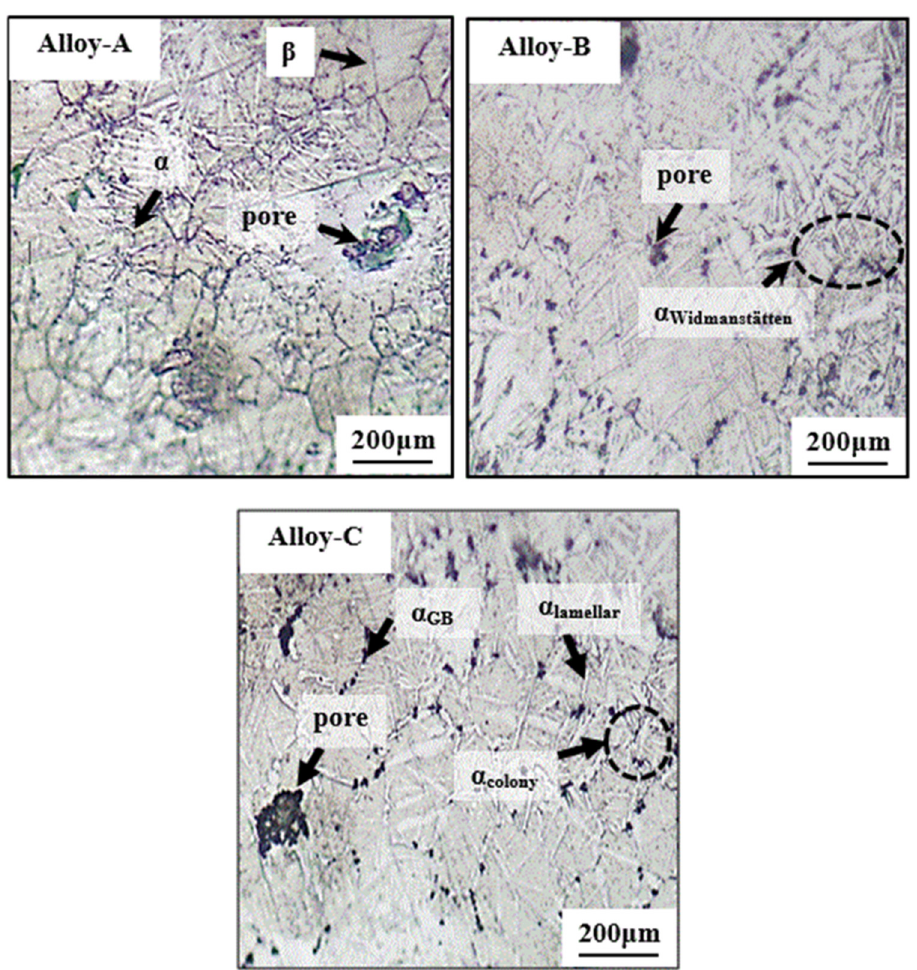
Figure 1. Optical micrographs of the experimental alloys fabricated by high-pressure spark plasma sintering (HFIHS) procedure.